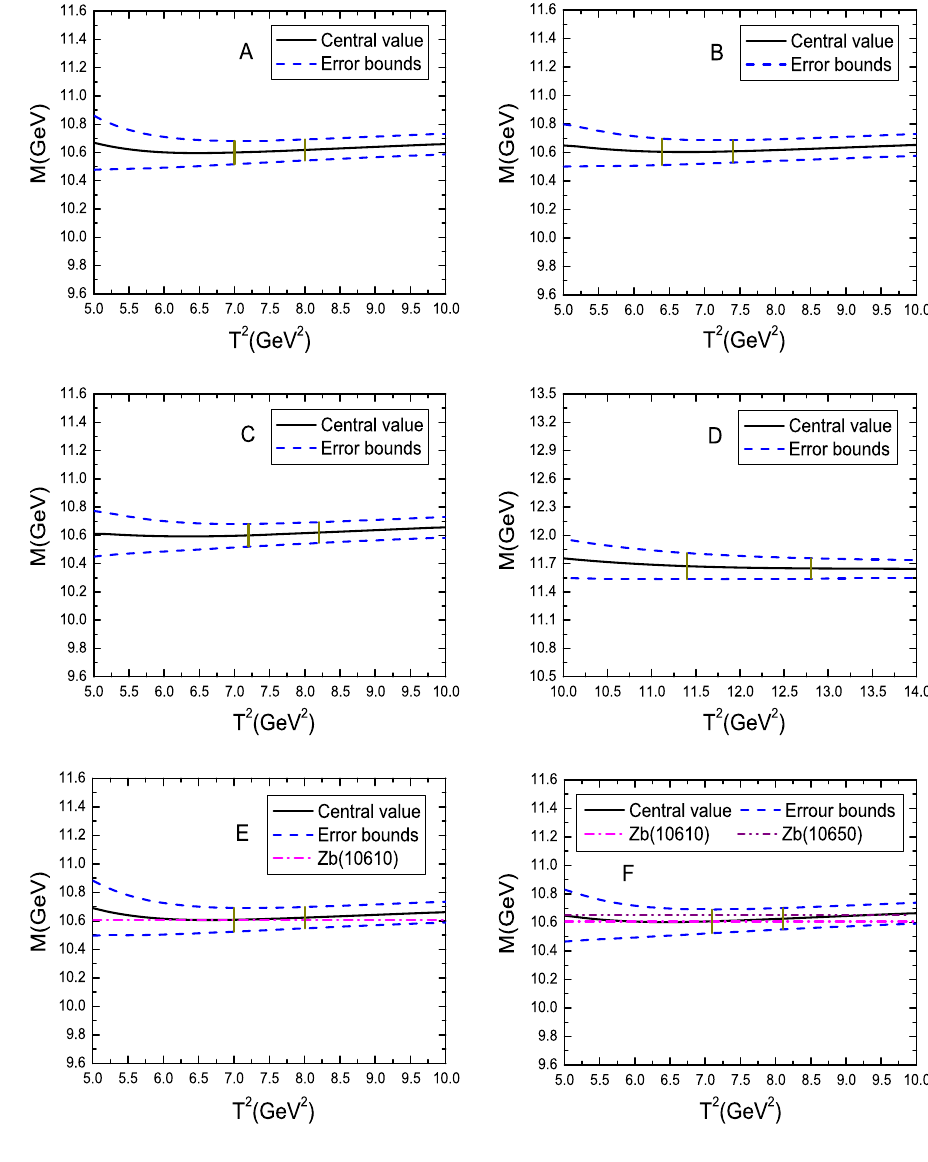
Fig. 1 The masses with variations of the Borel parameters T 2 for the hidden-bottom tetraquark states, the A , B , C , D , E and F denote the tetraquark states [ ub ] S [ db ] S